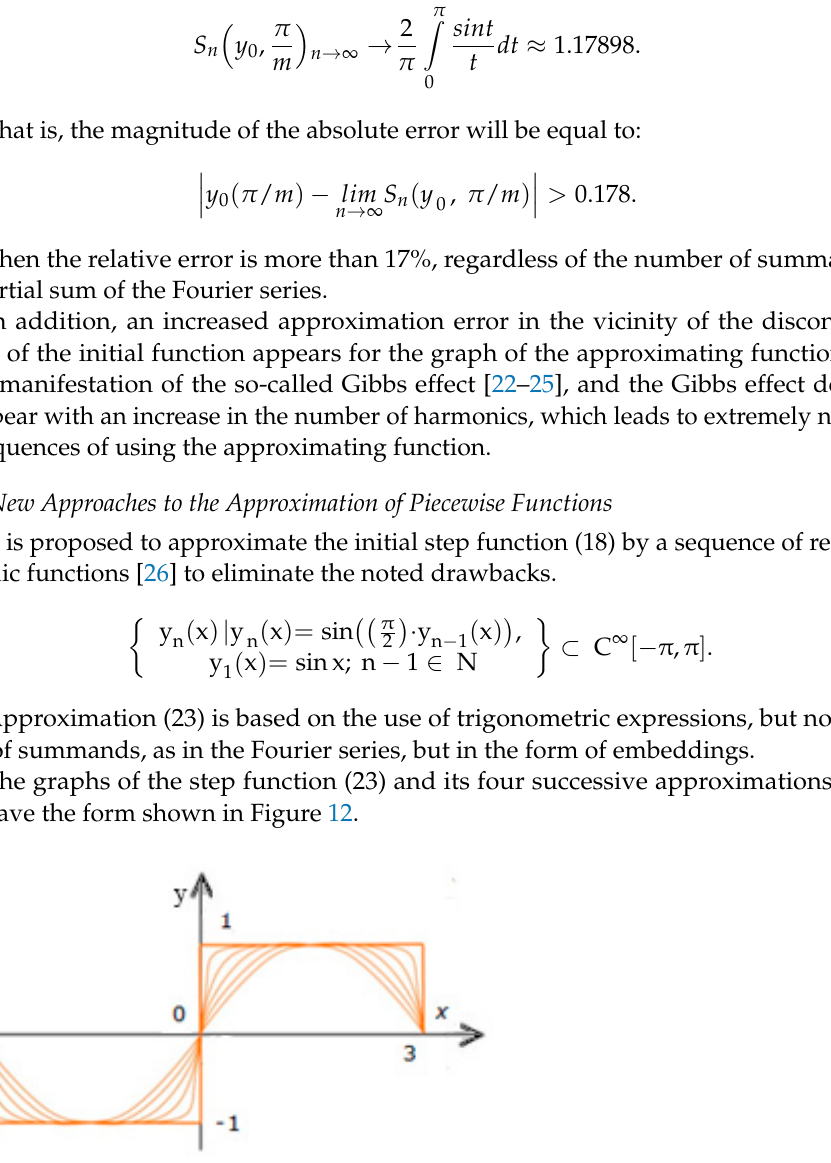
Figure 12. Graphs of a step function y = ∑ p ix nested functions.